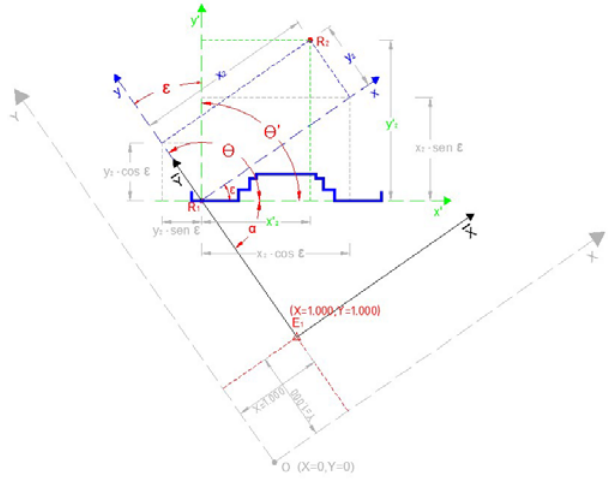
Figure 8. Scheme (floor plan) of arbitrary position and orientation of the total station reference system related with a building façade (cross section in blue).